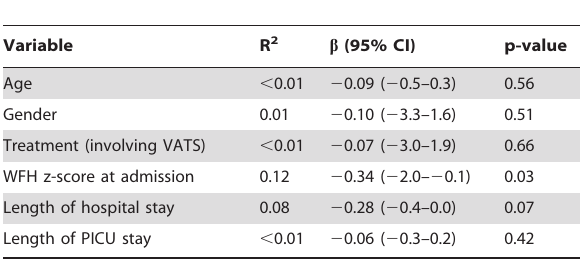
Table 3. Predictors of maximal % weight loss during